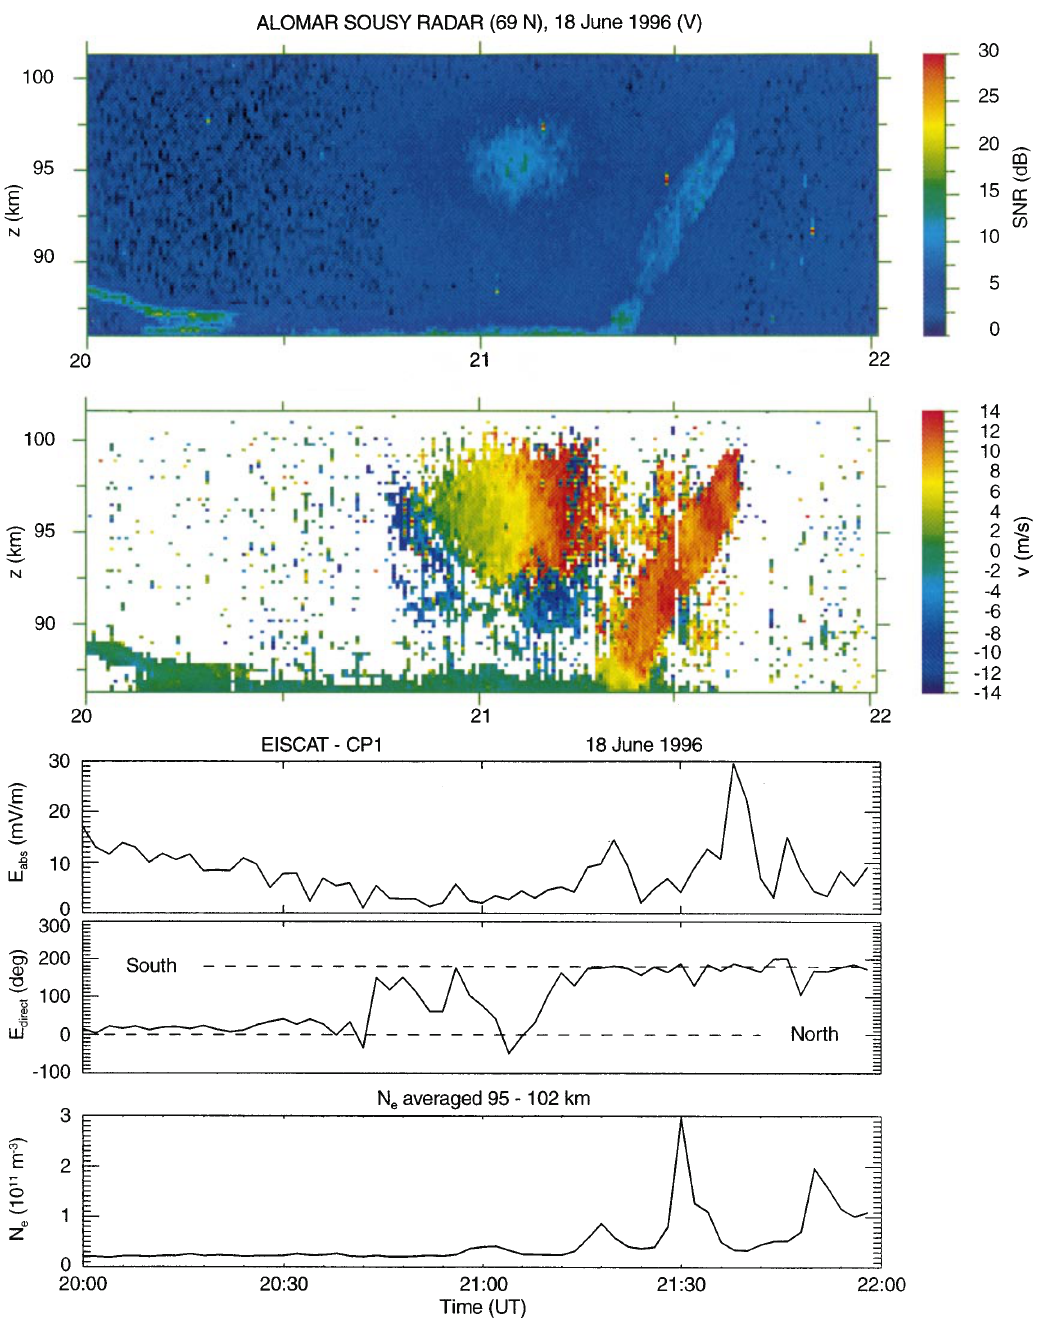
Fig. 2. Similar to Fig. 1, but for a second interval of backscatter occurring earlier on June 18. Electron temperature is omitted in this case, but vertical Doppler velocity of the scatterers ( second panel )